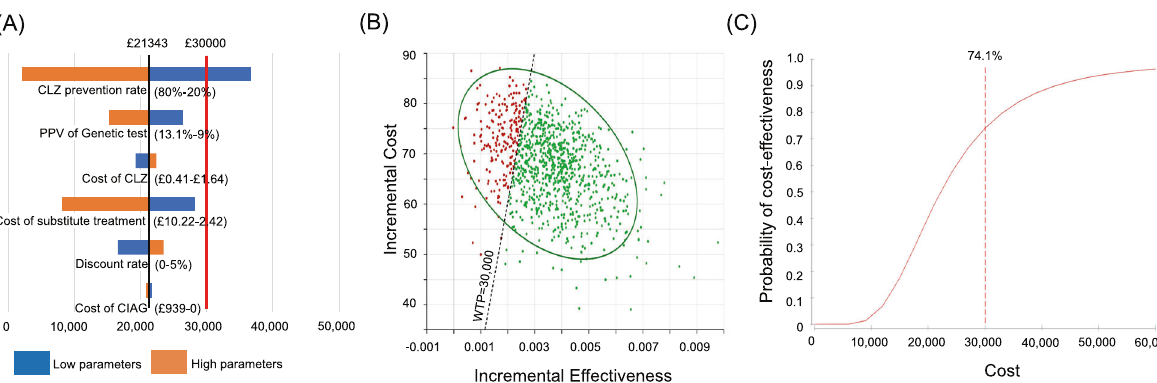
Fig. 3 Base – case scenario analysis in the UK. A Tornado plot of the one-way sensitivity analysis: the black vertical line indicates the incremental cost-effectiveness ratio (ICER) of the base-case analysis. The red vertical line indicates the cost-per QALY threshold. The numbers are the ranges used in the sensitivity analysis. The blue shaded bars represent lower parameters than those used in the base – case analysis, and the red shaded bars represent higher parameters than those used in the base – case analysis. B Scatter plot for incremental cost and effectiveness: green dots indicate ICERs within willing to pay threshold and red dots indicate out of the threshold. C Cost-effectiveness acceptability curve CLZ clozapine, PPV positive predictive value, CIAG clozapine-induced agranulocytosis/granulocytopenia, WTP willing to